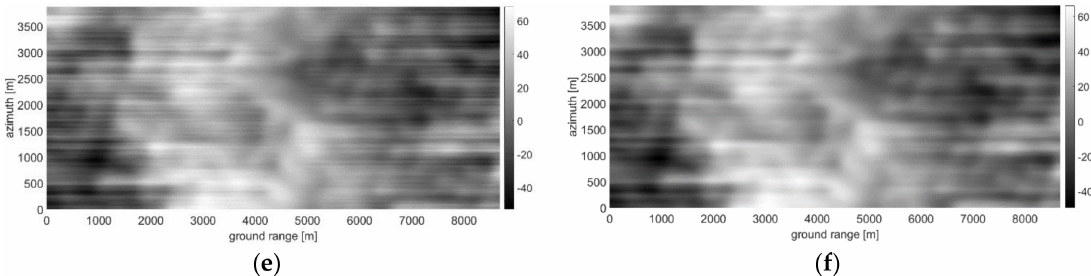
Figure 13. Estimated DEM assuming: speckle-free image and ( a ) unknown and ( b ) known starting points; Rayleigh-distributed speckle and known starting points: ( c , d ) unfiltered and ( e , f ) filtered cases, ( c , e ) before and ( d , f ) after azimuth regularization